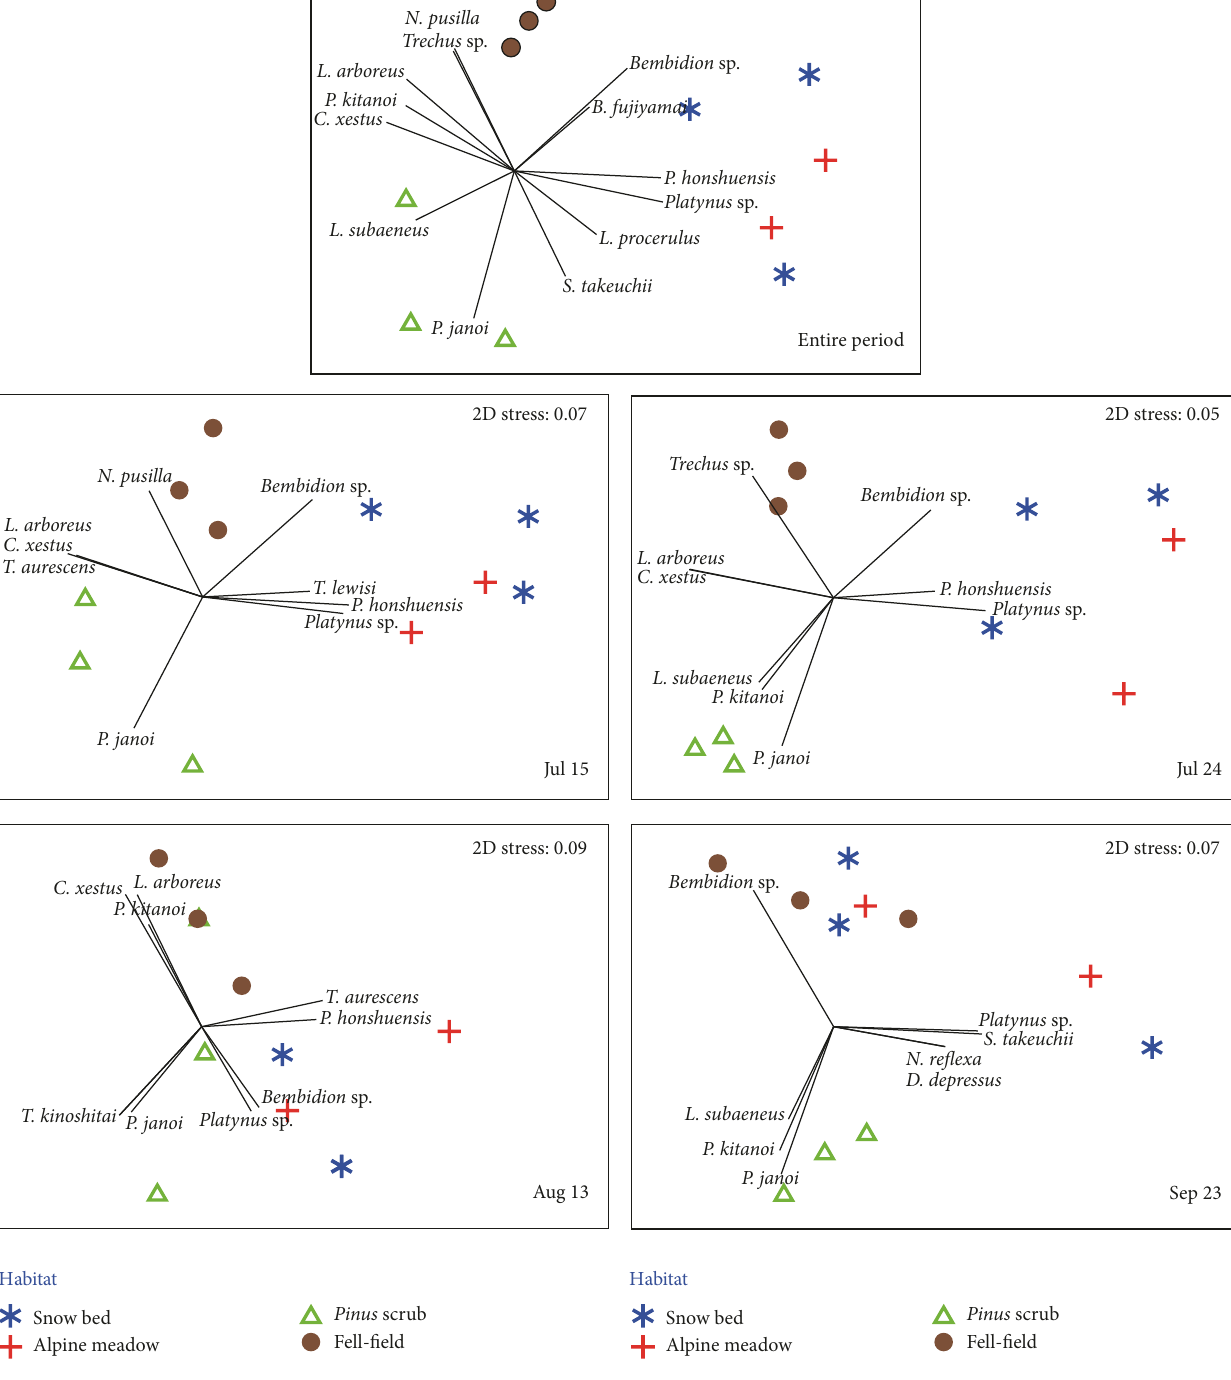
Figure 4: Nonmetric multidimensional scaling (NMDS) ordinations based on the abundance of carabid beetles on July 15, July 24, September 23, and the entire period (pooled data) on Mt. Hakusan. Only carabid beetle species with a Pearson correlation coefficient ≥ 0.6 are shown in the graphs. Vectors indicate the species that contributed significantly to discriminate the carabid beetle assemblages among the four habitats, with long vectors indicating the species with high contributions. The 2D stress indicates the model